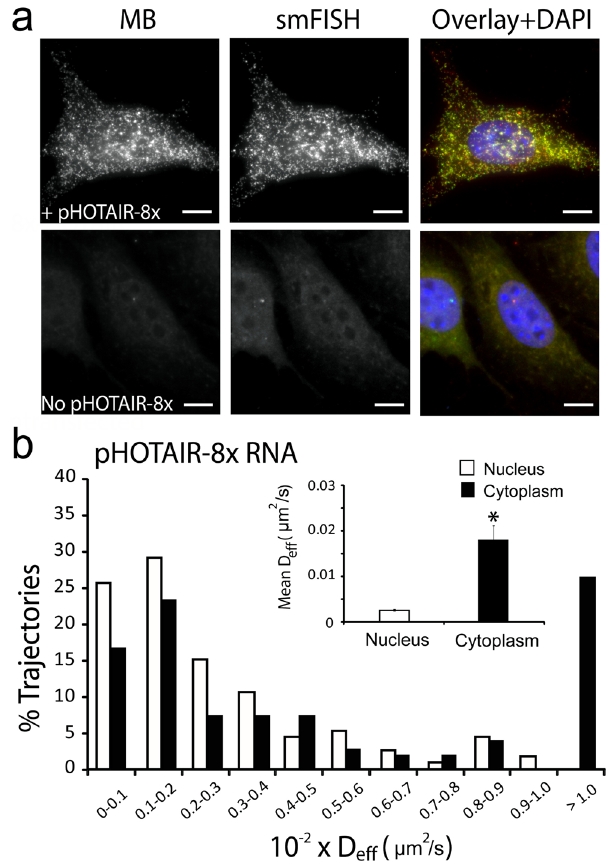
Figure 4. MB-based imaging of single HOTAIR transcripts in the nucleus and the cytoplasm. ( a ) Images of anti-repeat MBs for the detection of single pHOTAIR-8x transcripts. Following microporation of NIH3T3 cells with or without pHOTAIR-8x with 5 µ M of anti-repeat MBs, the cells were fixed and permeabilized and smFISH was performed to assess the accuracy of MBs for detecting single RNA transcripts. Representative maximum intensity projection images of MB and smFISH signals are shown. Note that in NIH3T3 cells not transfected with pHOTAIR-8x, lack of smFISH signal shows the specificity of the smFISH probes for the human HOTAIR transcript used. (Scale bar, 10 µ m) ( b ) Diffusion kinetics of single pHOTAIR-8x lncRNA transcripts in HeLa cells. HeLa-HOTAIR-8x cells were microporated with 5 µ M anti-repeat MBs, and time-lapse images were acquired 8 h after microporation. Single particle tracking analysis was performed to determine the diffusion coefficient of individual RNAs as described in Materials and Methods. The distribution of diffusion coefficients of single mobile pHOTAIR-8x RNAs in the nucleus (n = 113 tracks) and in the cytoplasm (n = 255 tracks) analyzed from 30 cells. Inset shows the mean ± SE diffusion